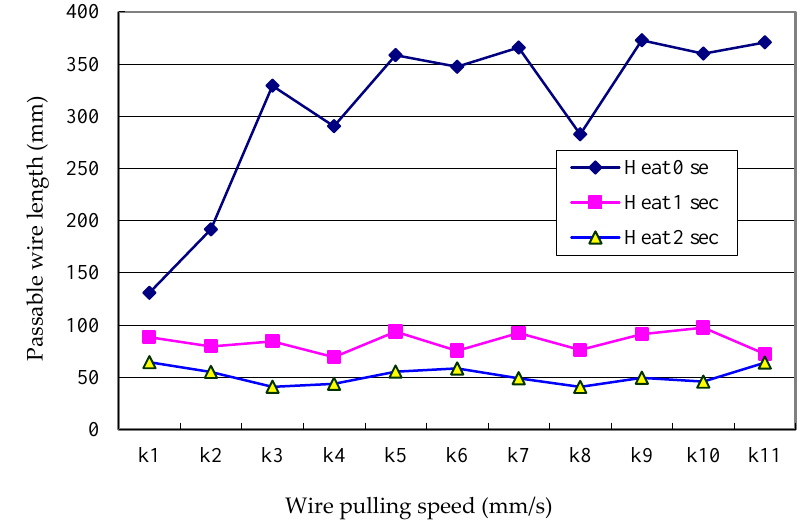
Figure 7. Passable wire length vs. wire pulling speed for the 0.3 mm wire at different heating periods.